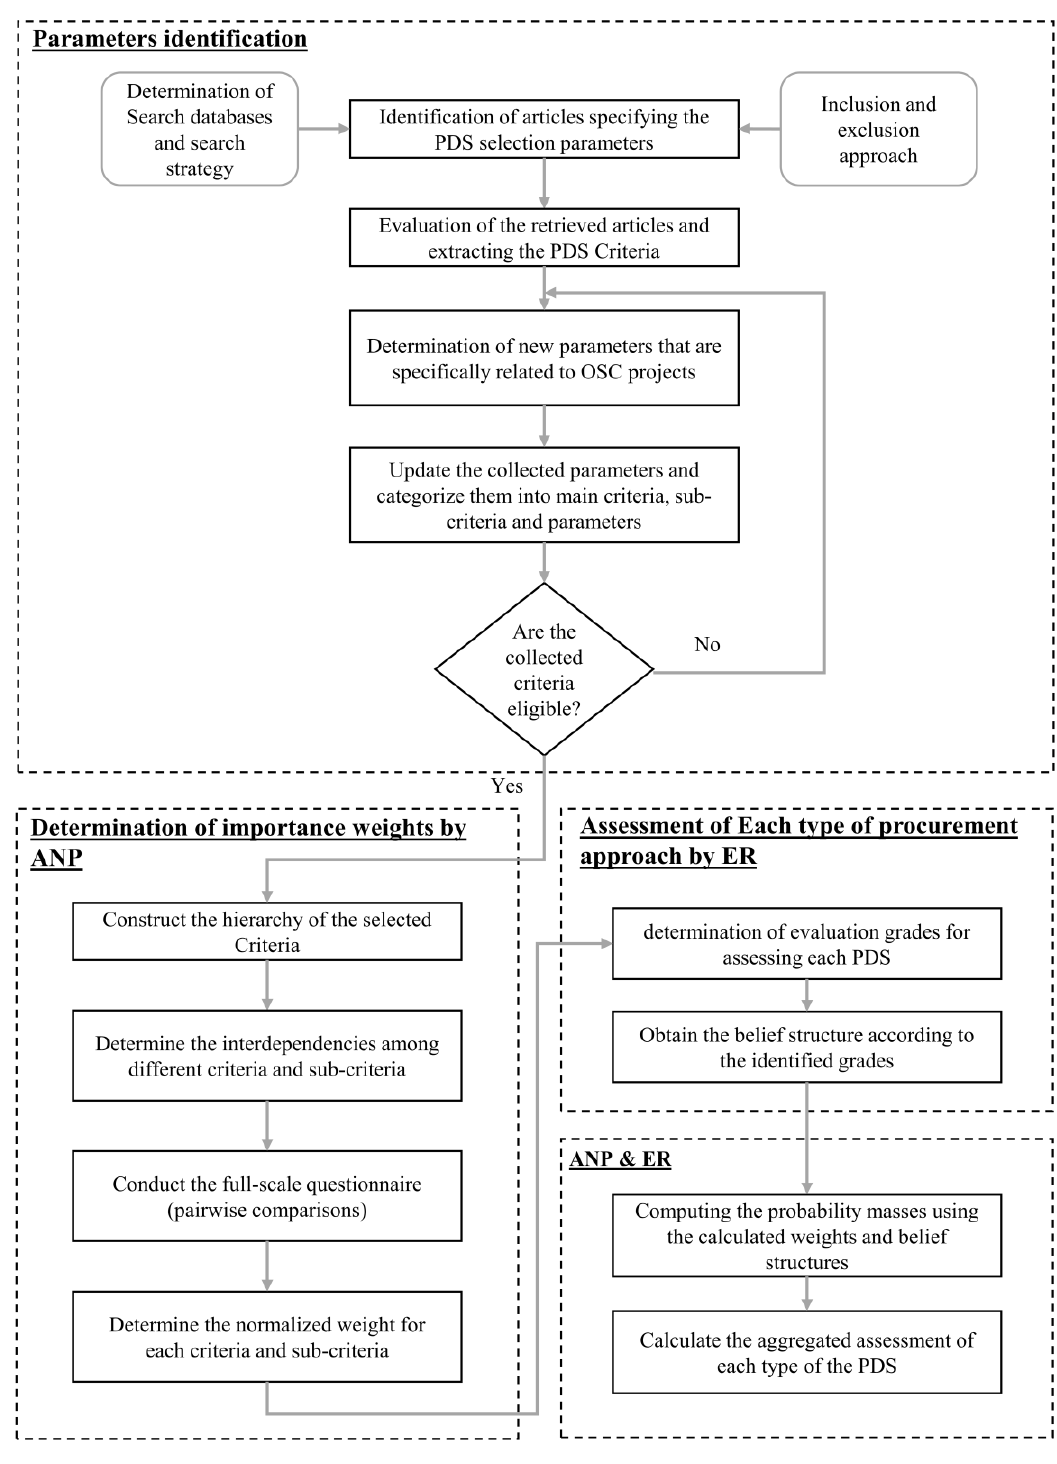
Figure 2. The overall framework of the research methodology .